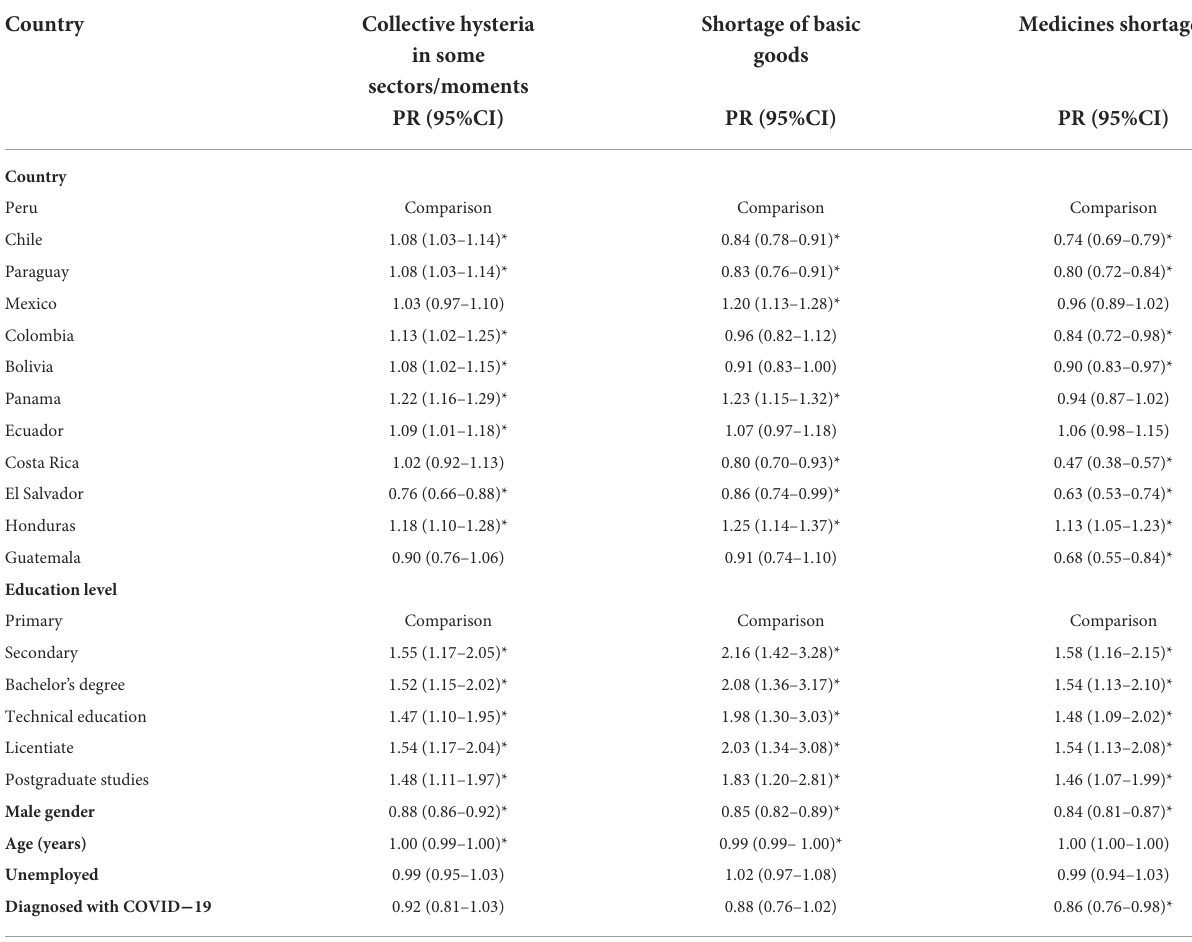
TABLE 3 Perception of collective hysteria and shortages in 12 Latin American countries during the first wave of the COVID-19 pandemic, in multivariate